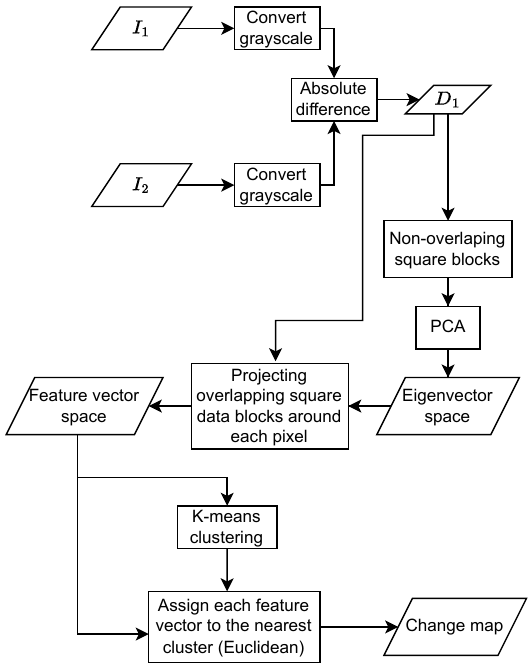
Figure 1. Unsupervised Change Detection Algorithm Proposed by Celik